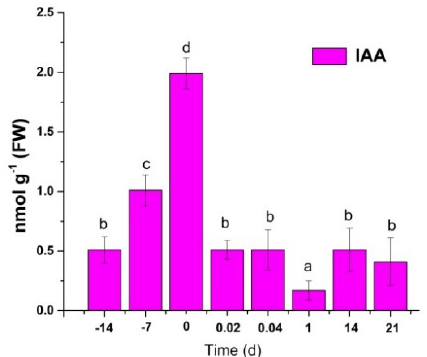
Figure 5. Endogenous auxin content during SE in C. canephora . A total of 100 mg of tissue was collected from the beginning of the preconditioning of the plantlets (days -14, -9, and -4) to the induction day (day zero). Samples were collected after the induction (0.02, 0.04, 1, 7, 14, and 21 d) of SE. The chromatographic system is described in Materials and Methods. All analyses were performed with three biological replicates from two independent experiments. FW, fresh weight; bars display standard error ( n = 3). Different letters represent the statistical significance of mean differences between each determination at a given time according to the Tukey test ( p < 0.05).